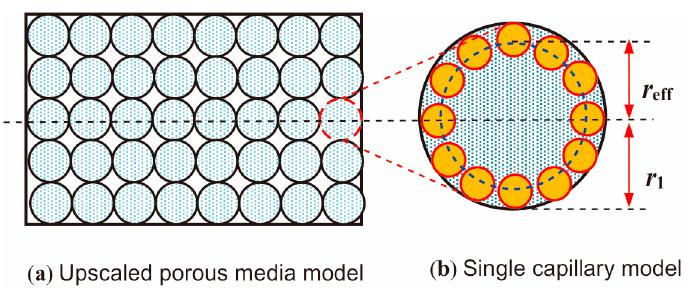
Figure 3. Scheme of upscaled porous media (UPM) model and single capillary model.